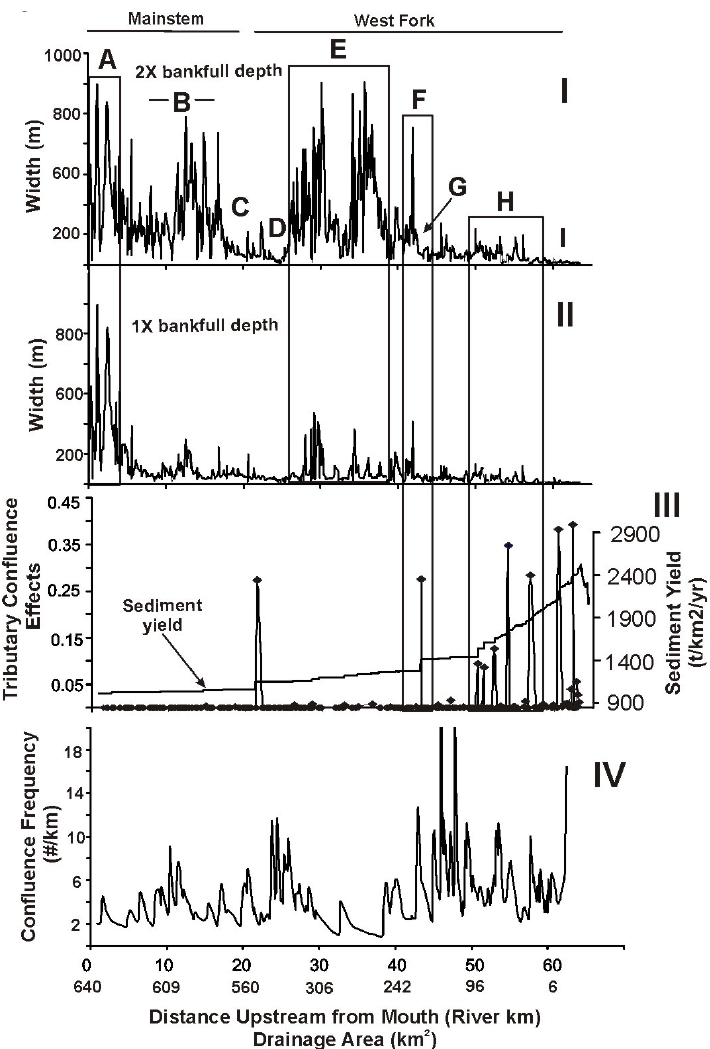
Fig. 3. The predicted fluvial landscape in the West Fork of the Pas River at an elevation above the channel equivalent to one and two bankfull depths is highly variable (I, II) . The predicted tributary confluence effects and average sediment yields (using a catchment wide average of 1000tkm − 2 yr − 1 ) are shown in (III) . The spatial frequency of tributary intersections along the Mainstem and West Fork study segments shows a clumped pattern (IV) . Site locations A–I are mapped in Fig.